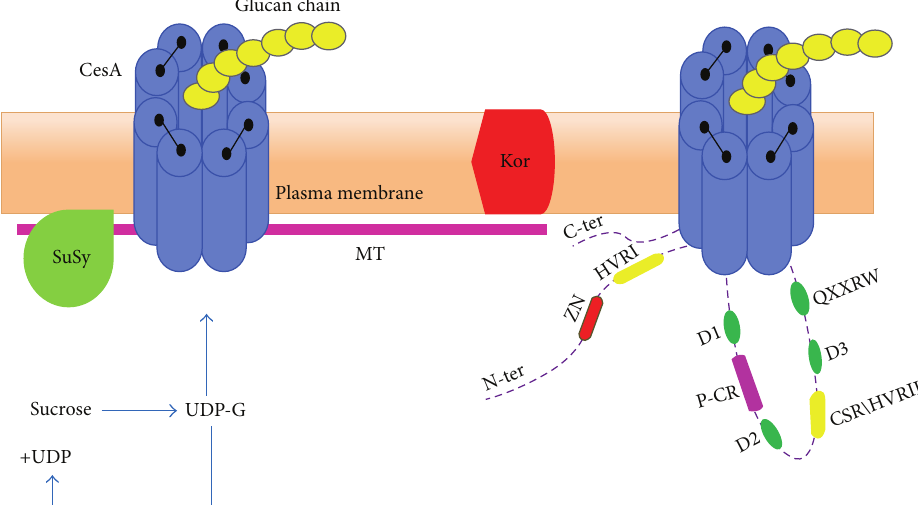
Figure 1: Model for structure of CesA proteins (right) shows a conserved zinc finger domain (ZN) and a hyper variable region (HVR Ι ) near N-ter of TM1-2 and short C ter of TM3–8 and central hypervariable region (HVR ΙΙ ), plant-specific conserved region (P-CR), and class specific region (CSR); position of the processive glycosyltransferase motif D,D,D,QXXRW. Plant’s cellulose biosynthesis (left). The plasma membrane- associated sucrose synthase (SuSy) channels uridine diphosphate-glucose (UDP-G) substrate to form rosette and glucan chain formation, the UDP formed can be recycled back to SuSy, and Korrigan cellulase (Kor) has been involved in monitoring of cellulose synthesis. Microtubules (MT) play role to regulate CesA proteins trafficking [2, 54,